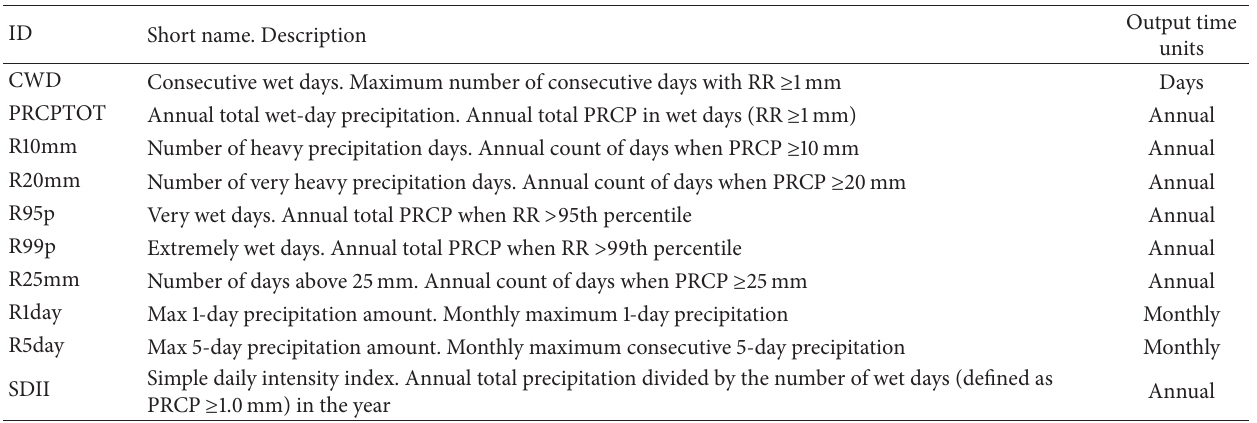
Table 2: Acronyms and short descriptions of the ten precipitation-based